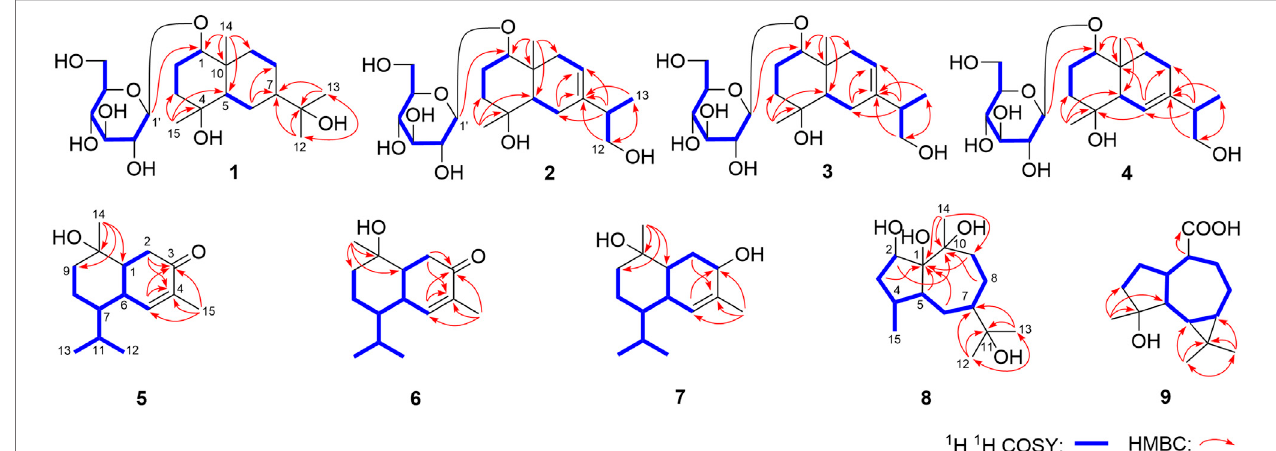
FIGURE 3 | The main 1 H 1 H COSY and HMBC correlations of 1 – 9